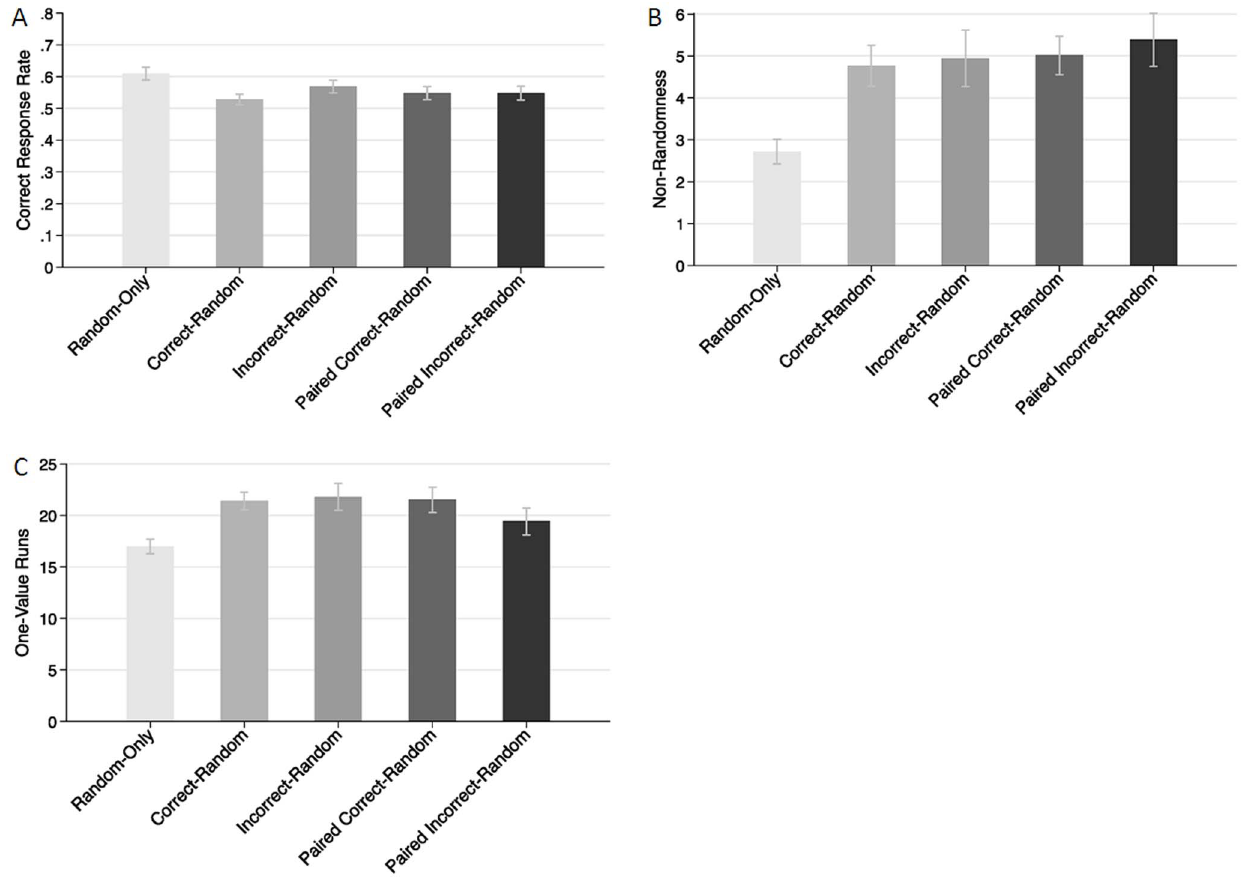
Figure 5. Means for (A) correct response rate, (B) non-randomness, and (C) one-value runs by experimental condition (Experiment 3). Error bars are standard errors of the means.